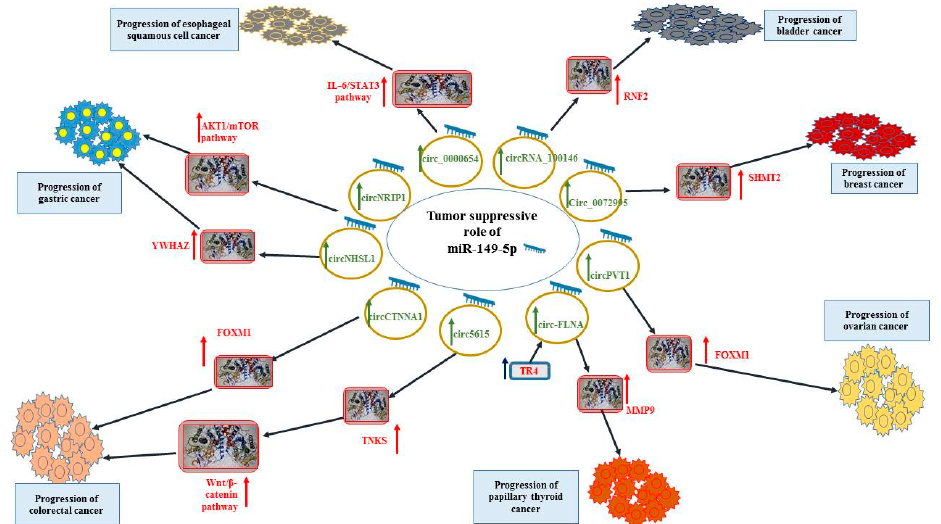
Figure 1. Tumor-suppressive role of miR-149-5p in esophageal cancer, bladder cancer, breast cancer, ovarian cancer, thyroid cancer and colorectal cancer.